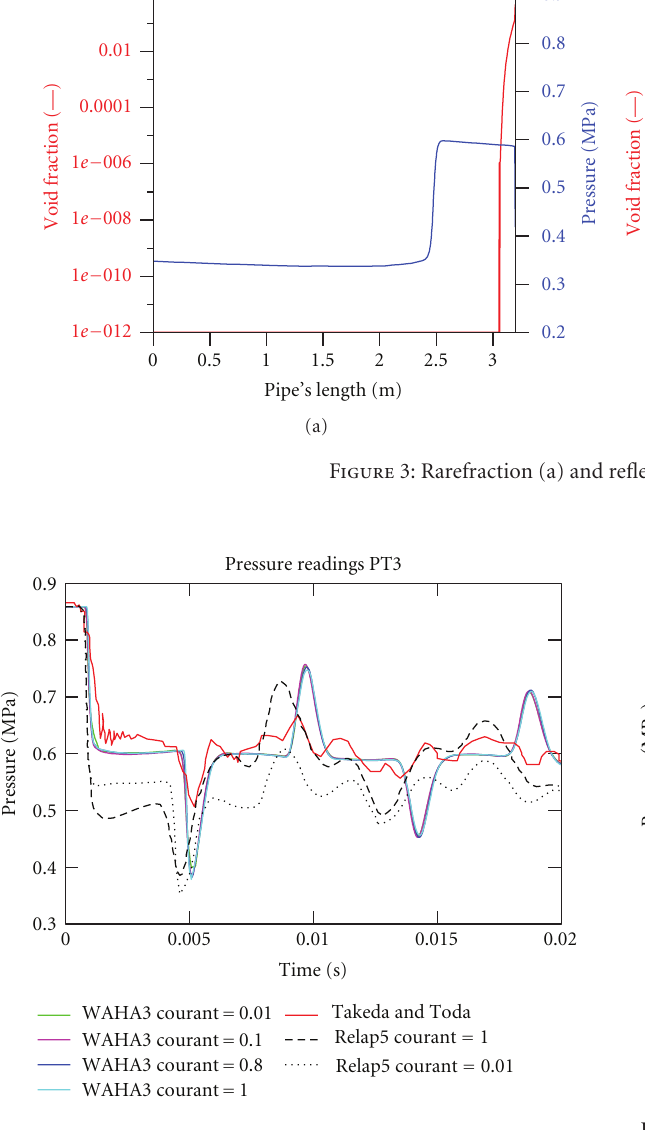
Figure 5: Simulation of results using di ff erent orders of